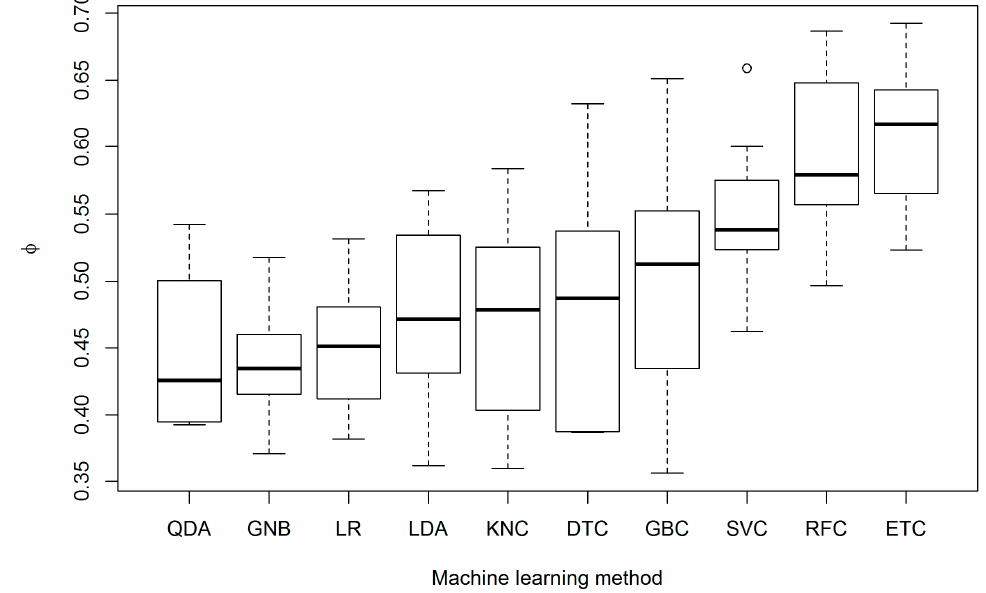
Figure 3. Boxplot of phi coefficients ( φ ) of the top FDMs generated by MLAs. Box plots show median plus upper and lower quartiles of the phi coefficient for the period 2003–2012. Minimum and maximum values are indicated by the upper and lower whiskers (1.5 × interquartile range). Circles are outliers. The MLA codes are given in Table 3.